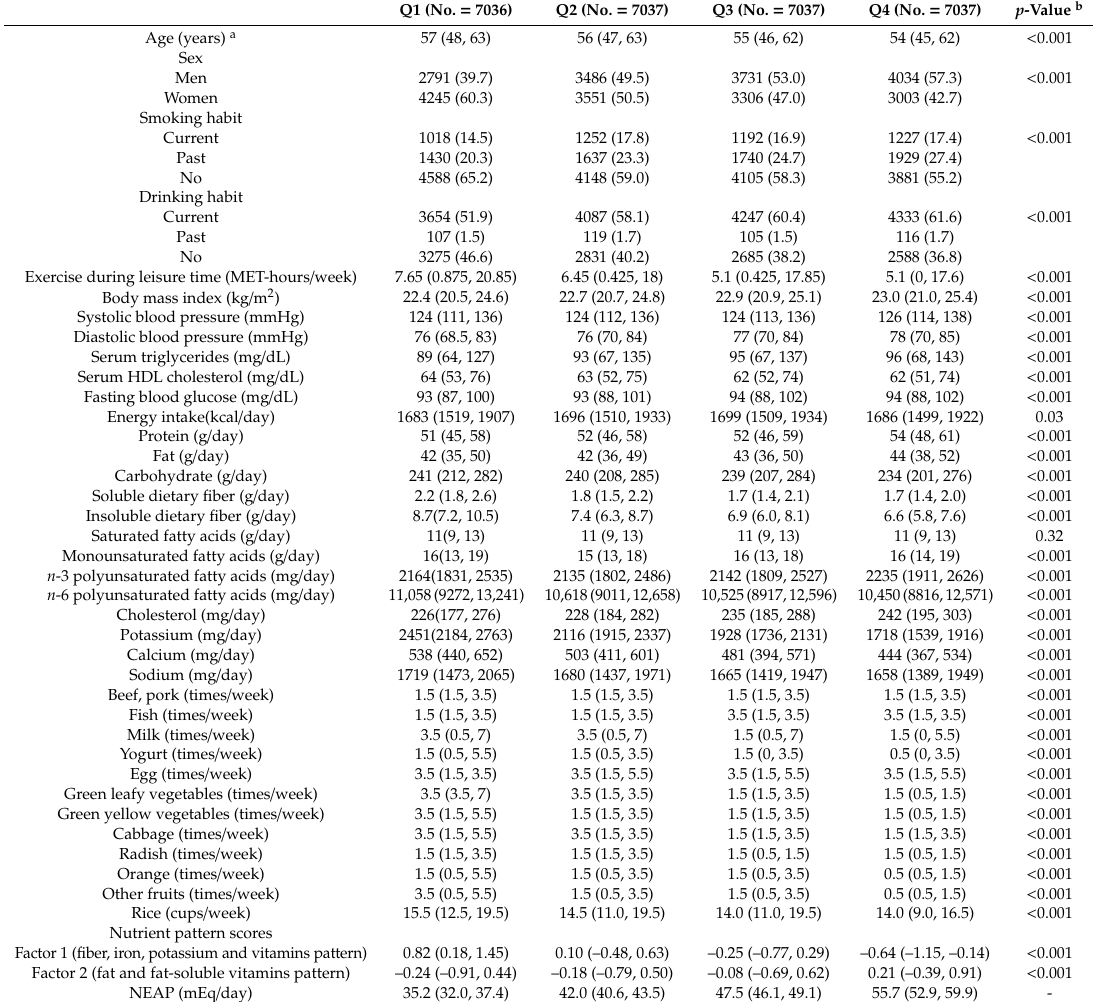
Table 1. Background characteristics of the study subjects according to their Net Endogenous Acid Production (NEAP)